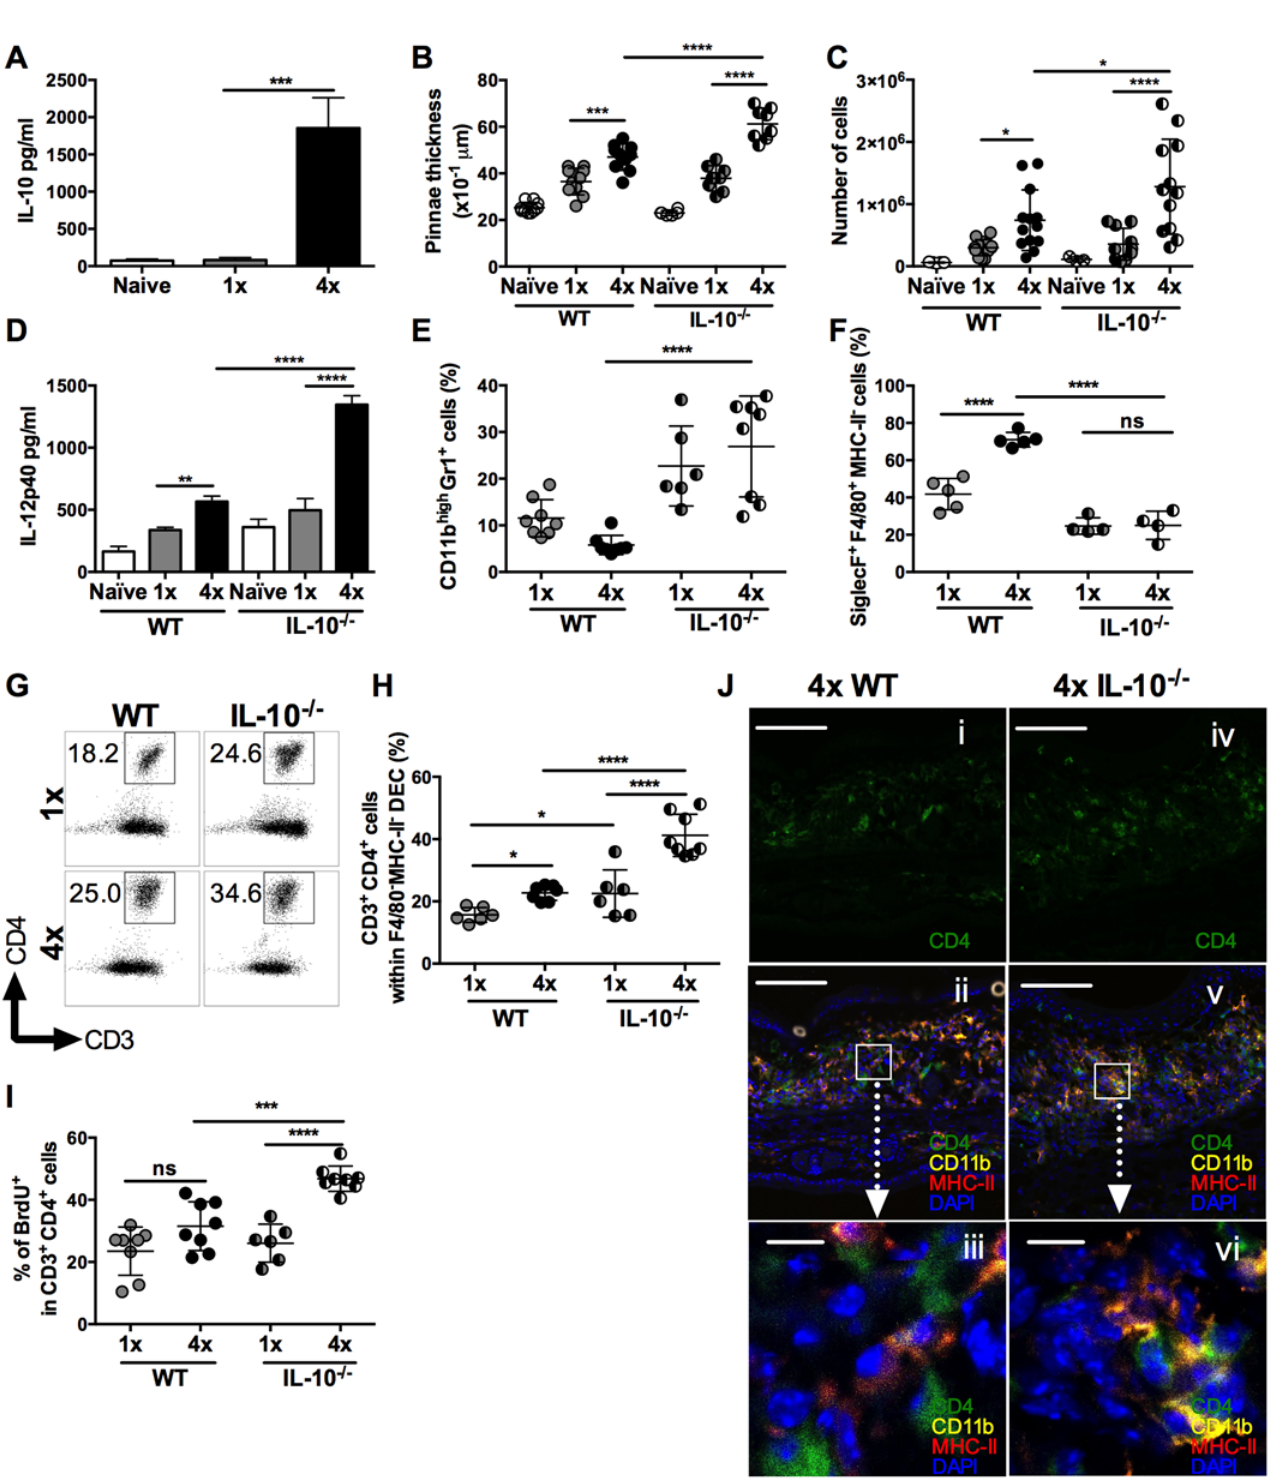
Fig 1. IL-10 produced in the skin following repeated exposures to S . mansoni cercariae limits CD4 + T cell proliferation and mediates recruitment of granulocytes. ( A ) IL-10 released from overnight in vitro cultures of skin (pinnae) biopsies from na ï ve, 1x or 4x infected mice measured by ELISA. Data are means +SEM (6 – 8 pinnae per group). ( B ) Pinnae thickness (x10 -1 μ m) (n = 8 pinnae) and ( C ) DEC numbers (n = 6 – 13 pinnae) for na ï ve, 1x and 4x infected WT, or IL-10 -/- mice, on day 4 post-final exposure. Symbols are values for individual tissue samples; horizontal bars are the means ± SEM. ( D ) IL-12p40 detected in overnight cultures of skin biopsies from naive, infected 1x, or 4x WT and IL-10 -/- mice. Values are means +SEM (n = 8 pinnae). ( E ) CD11b high Gr1 +